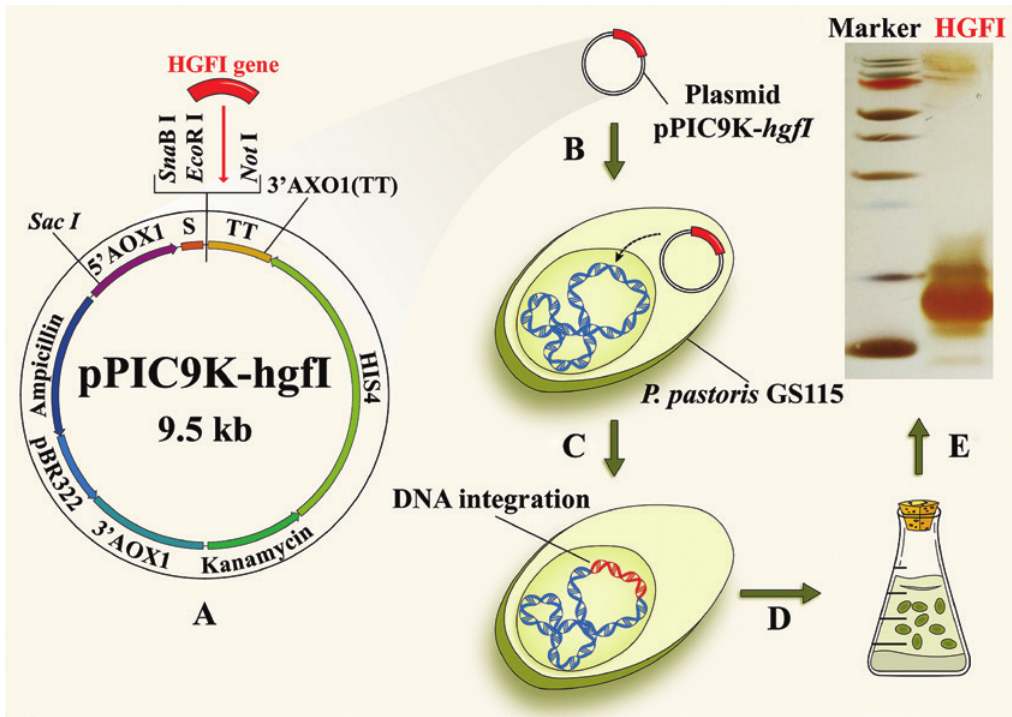
Figure 1: Illustration of HGFI expression, purification, and identification. (A) Insert the gene containing HGFI into plasmid DNA. (B) Transform recombinant plasmid into P. Pastoris . (C) Plasmid integration. (D) Selection of positive transformed colonies and expression of HGFI. (E) Purification and identification of